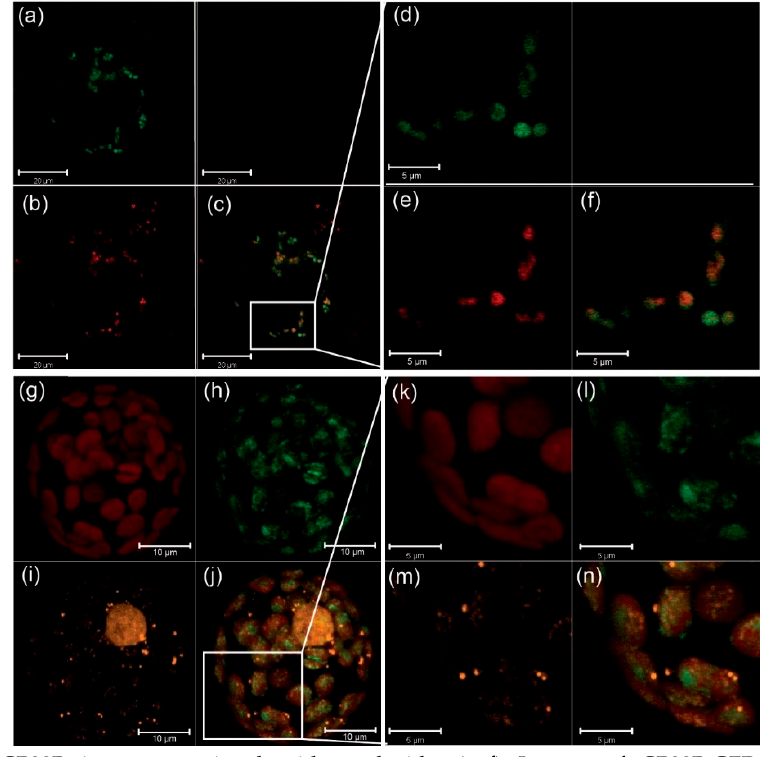
Figure 2. CP33B is not associated with nucleoids. ( a–f ) Images of CP33B:GFP ‐ transformed Arabidopsis protoplasts. ( d ), ( e ), and ( f ) are enlargements of the white box area of ( c ) respectively. GFP fluorescence (a and d, green); chlorophyll autofluorescence (b and e, red); superimposition of images ( a ) and ( b ) in ( c ), and ( d ) and ( e ) ( f ), respectively. ( g–n ) Images of co ‐ transfection experiments of CP33B:GFP and PEND:dsRed. (k), (l), (m) and (n) are enlargements of the white box area of ( g–j ). Chlorophyll autofluorescence (g and k, red); GFP fluorescence (h and l, green); dsRed fluorescence (i and m, orange); superimposition of images g ‐ i (in j) and k ‐ m (in n), respectively. The white bars represent 20, 10 and 5 μ m, as indicated.